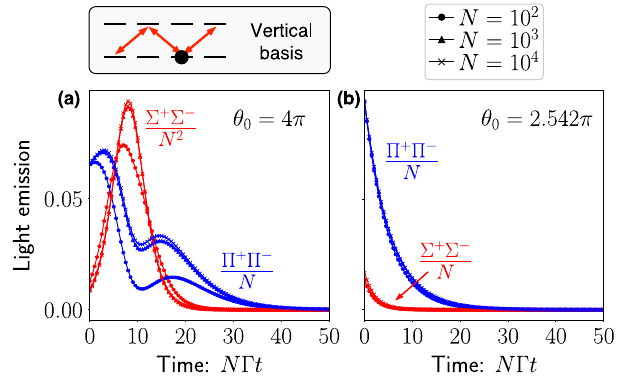
FIG. 11. Light in orthogonal polarization. Cumulant results are 3 = 2 starting in F shown for the eight-level system with F g ¼ e ¼ ˆ Σ (cid:2) and being initially excited by a drive. We plot the light j g 1 = 2 i V ˆ Σ þ ˆ Σ − ˆ Π þ ˆ Π − intensity in both polarizations, h i (red) and h i (blue), for different atom numbers N (markers shown in legend). The different polarizations are scaled differently with N as indicated in the plots. The collapse of the curves demonstrates the corresponding N scaling. Panel (a) shows results for θ 0 ¼ 4 π , which is a nondark state. Panel (b) shows θ 0 ¼ 2 . 542 π , which corresponds to a minimum of V ð θ Þ , i.e., a MF dark state; see potential in Fig. Fig. 10(a). As demonstrated by the collapse of the ˆ Σ þ ˆ Σ − curves when rescaling as h i =N 2 (red), the atoms